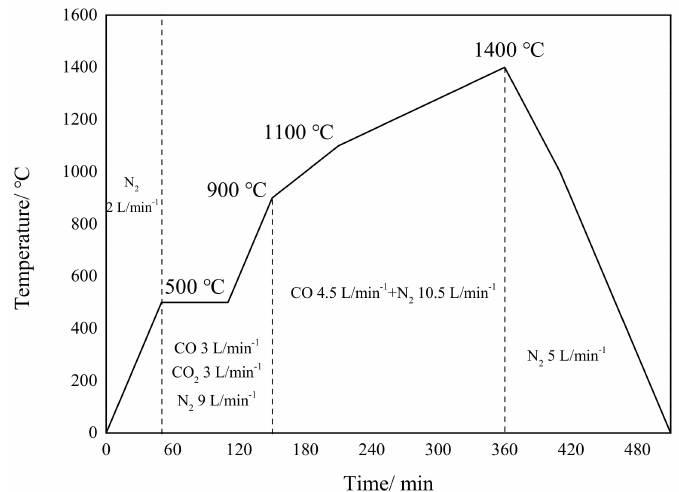
Figure 3. Temperature and gas − flow profiles programmed for each